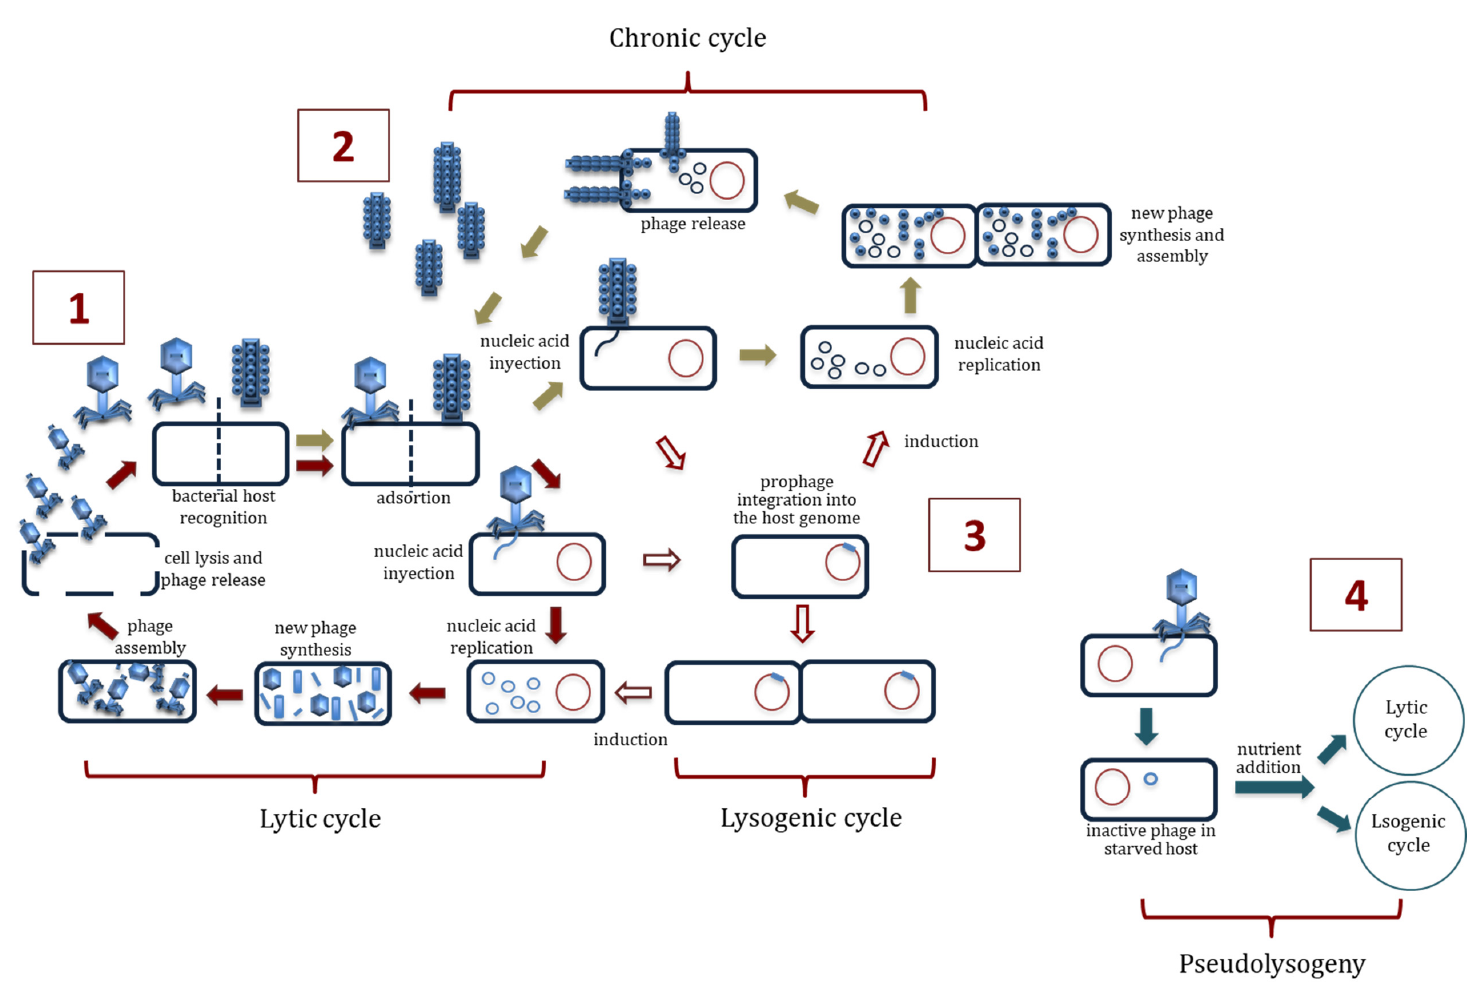
Figure 1. Phage–host interactions. ( 1 ): Lytic cycle. ( 2 ): Chronic cycle. ( 3 ): Lysogenic cycle. ( 4 ): Pseudolysogeny.